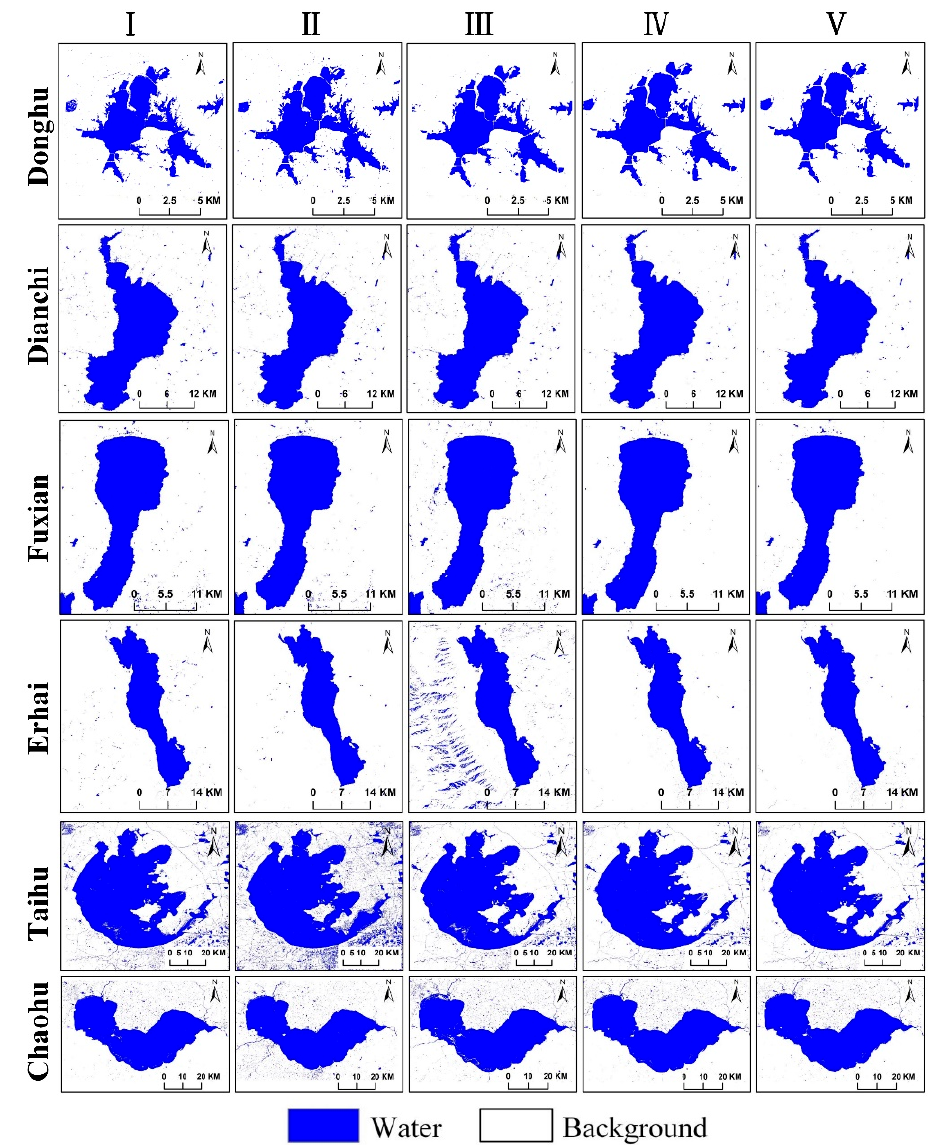
Figure 7. Comparison of LWB extraction results for Methods I–V at each of the six test sites.